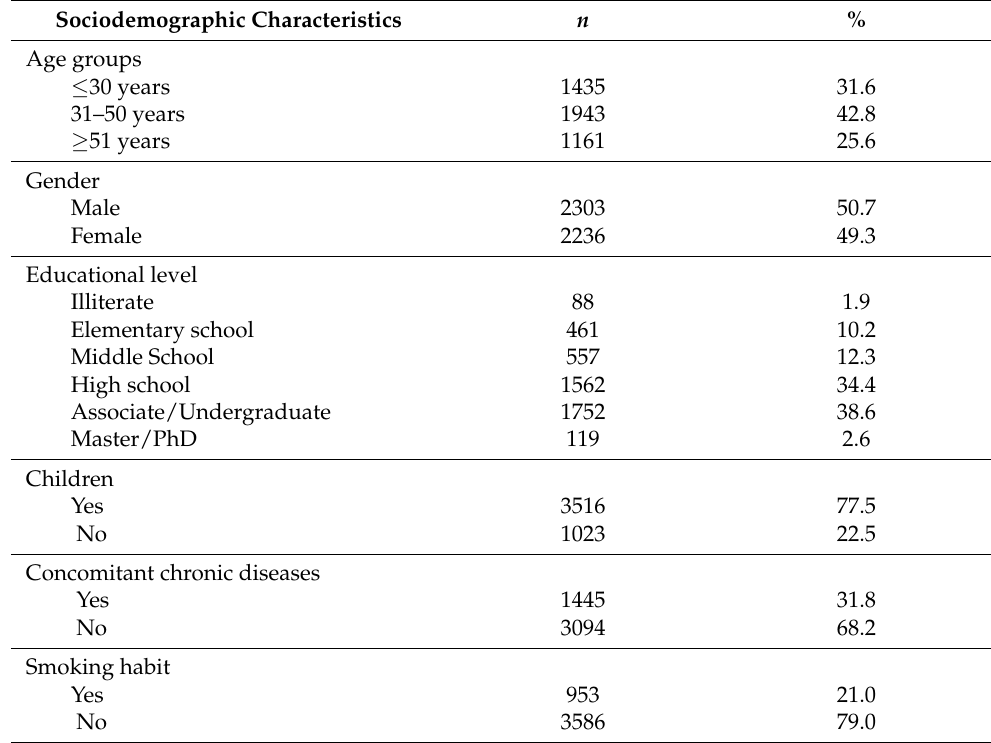
Table 2. The sociodemographic characteristics of the